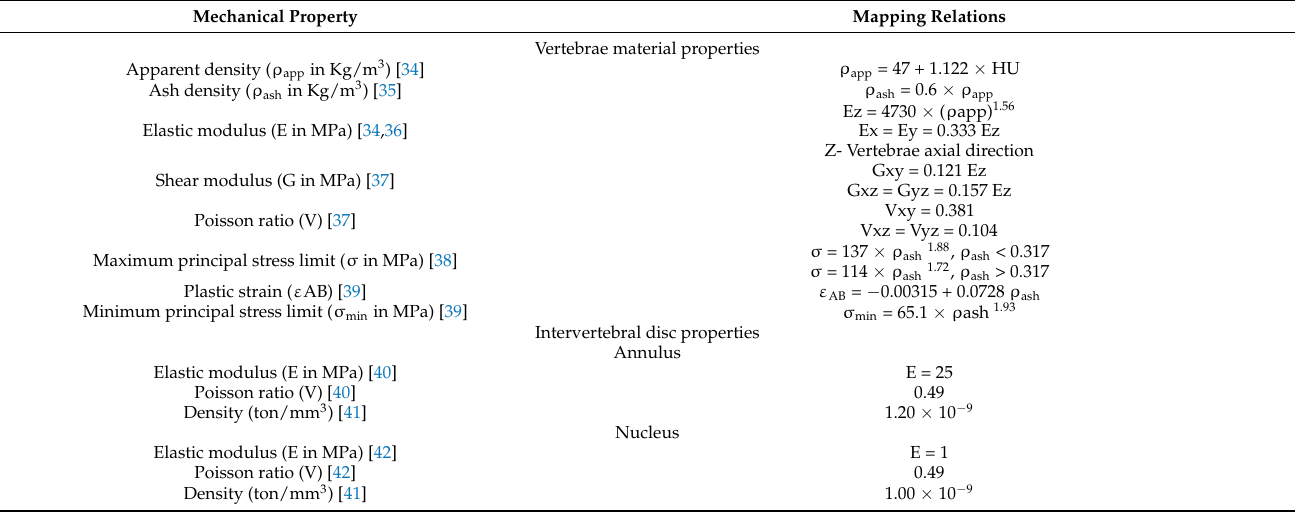
Table 1. Elastic constants and material mapping relations used in modeling vertebrae and IVDs in this study. The density values were calculated from Hounsfield units (HU), and then the modulus and stress values were derived from densities.